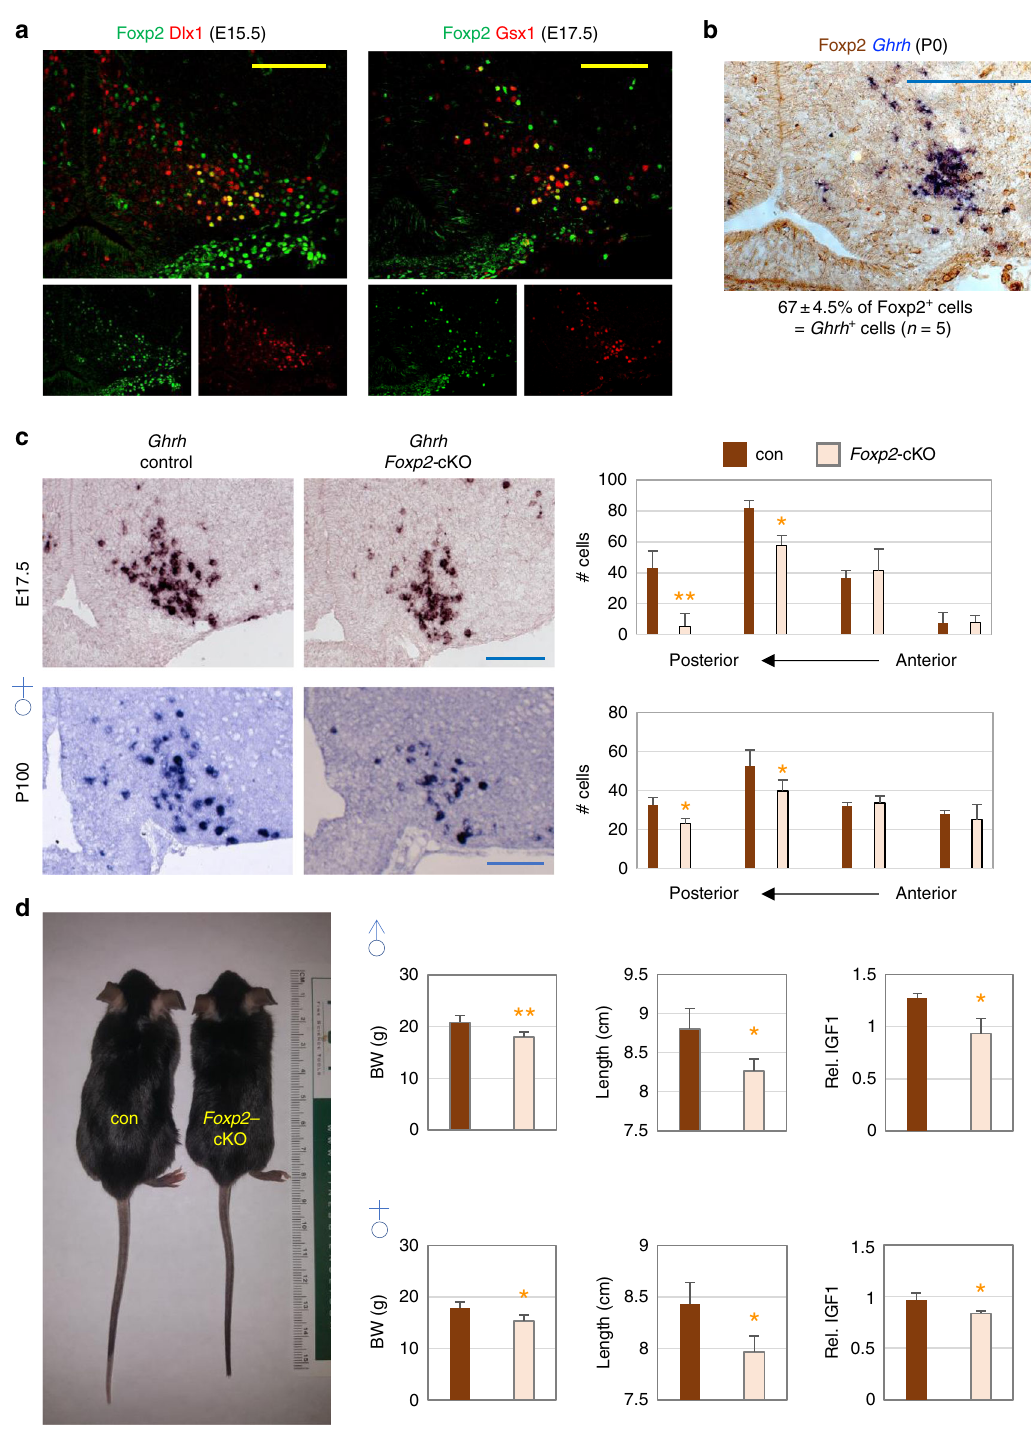
Fig. 5 Crucial roles of Foxp2 in the development of Ghrh-neurons. a IHC with antibodies against Foxp2 and either Dlx1 or Gsx1 reveals co-expression of Foxp2 and Dlx1/Gsx1 in a subset of E15.5/E17.5 ARC neurons. b ISH for Ghrh (blue) combined with IHC against Foxp2 (brown) reveals co-expression of Foxp2 with Ghrh in P0 ARC. c ISH against Ghrh reveals that the number of Ghrh + cells (i.e., Ghrh-neurons) in the ARC is signi fi cantly reduced in Foxp2 -cKO mice relative to control mice at both E17.5 and P100 (in both sexes). The number of mice per each genotype was 3 – 5. The distance between serial sections was 132 μ m, and the images shown are for the second posterior sections. d Dwar fi sm of P50 Foxp2 -cKO male and female mice, accompanied by signi fi cant reductions in body weight (BW), linear growth (length, cm), and the relative expression levels of IGF1 in the liver. The number of mice for each genotype was 3 – 5. All scale bars are for 100 μ m. Statistical differences were determined by Student ’ s t -test ( c , d ); p < 0.05 (one asterisk) and p < 0.01 (two